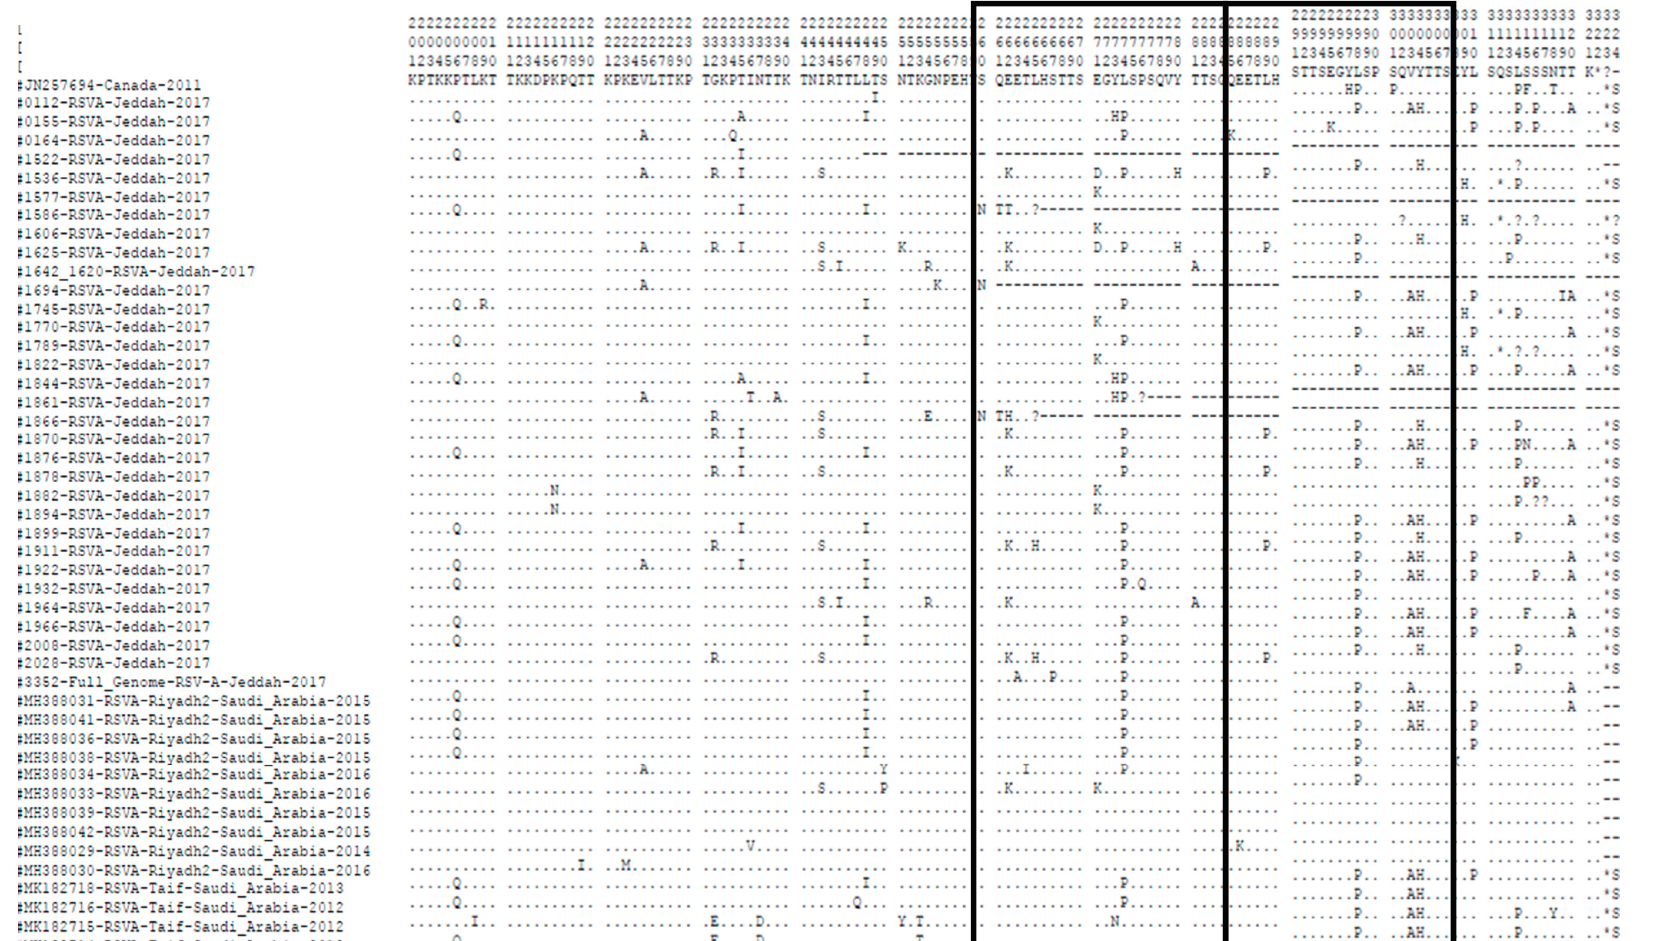
Figure 4. The sequences alignment of deduced amino acid in the second hypervariable region of the G protein of he RSV-A group for the ON1 strain are shown to correspond to the prototype strain of ON1 from Canada (GenBank accession number JN257694). The positions of the amino acids correspond to 213–320 of the G protein. Dots indicate identical residues, and asterisks indicate the position of stop codons. Boxes frame the 24 amino acid duplicated region.